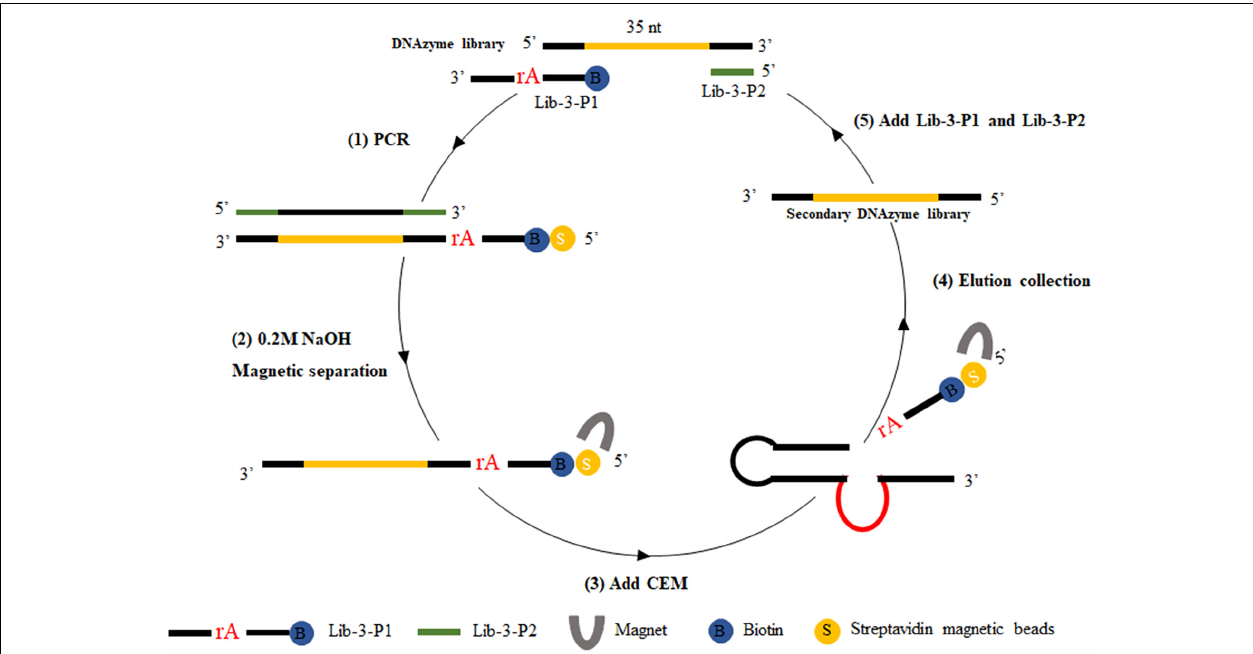
FIGURE 1 | CEM-VV-specific DNAzyme selection. Briefly, (1) biotin-containing tags were fixed to the original DNAzyme library by polymerase chain reaction (PCR), which could be attached to the streptavidin-coated magnetic beads. (2) The magnetic beads were washed with 0.2 M NaOH to remove the DNA chain, which was not connected. (3) DNA was bound to crude extracellular mixtures of Vibrio vulnificus (CEM-VV) to form a specific structure, resulting in a cleavage reaction. (4) Magnetic separation and alcohol precipitation were used to recover DNA as a library of next round selection. (5) Lib-3-P1 and Lib-3-P2 were added for polymerase chain reaction (PCR), and the next round of selection was